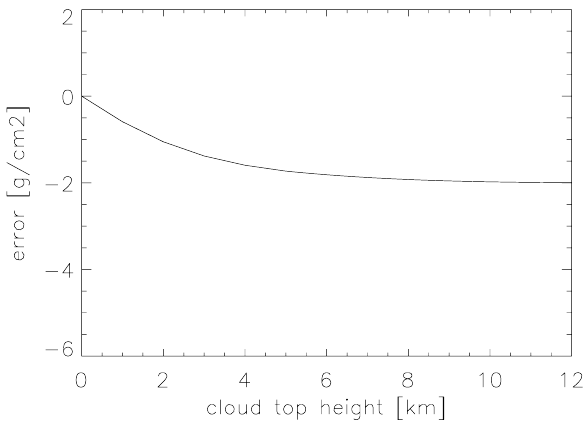
Fig. 6. Estimate of the error in the water vapour column as a func-